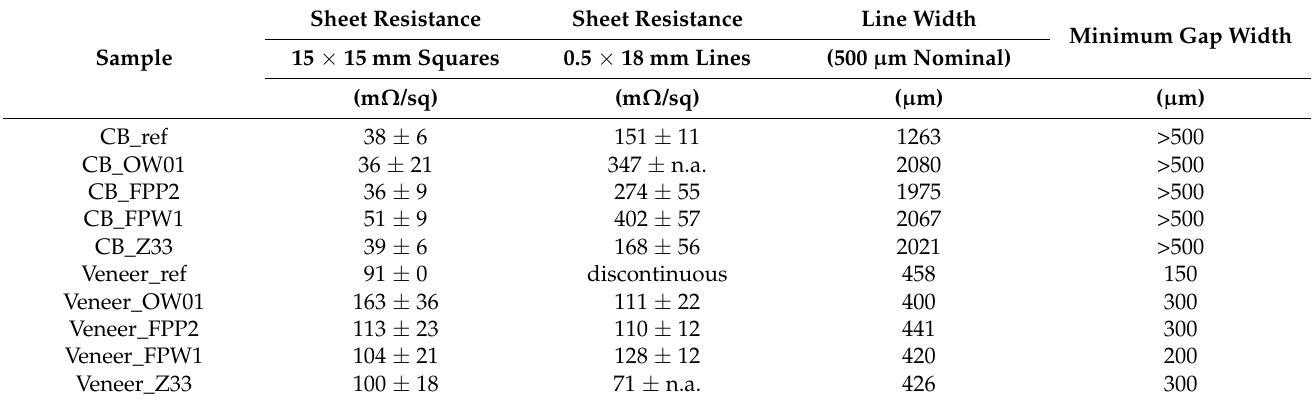
Table 3. Sheet resistance and line quality for the screen-printed samples.